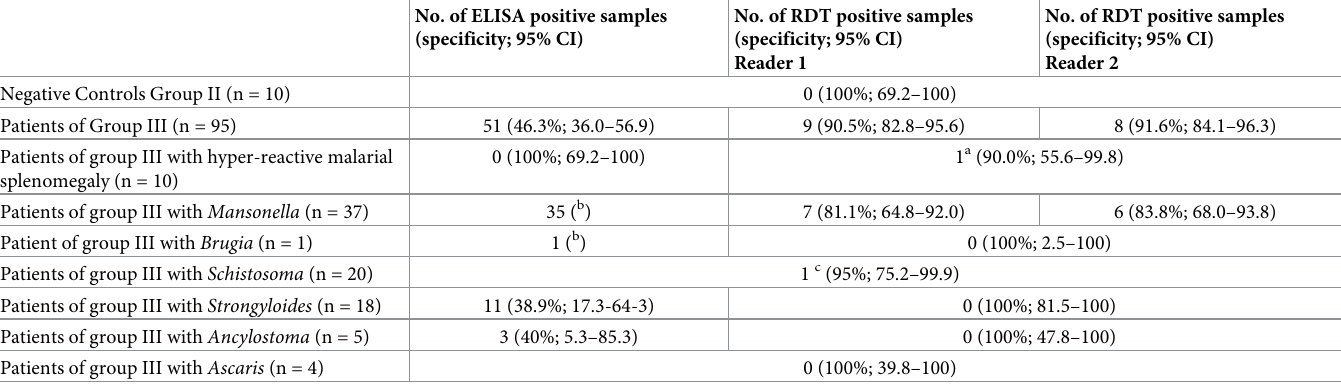
Table 2. Specificity of the RDT and ELISA test by infection type.